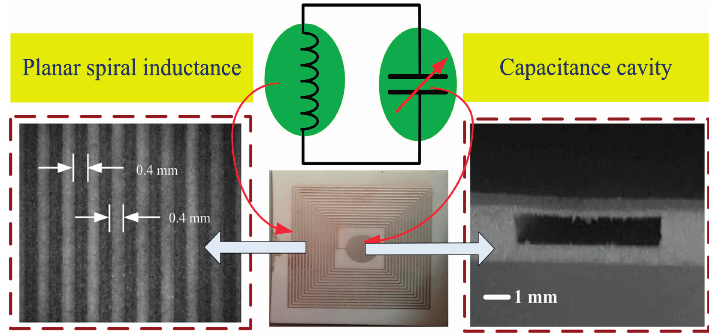
Figure 3. Wireless passive LC ceramic pressure